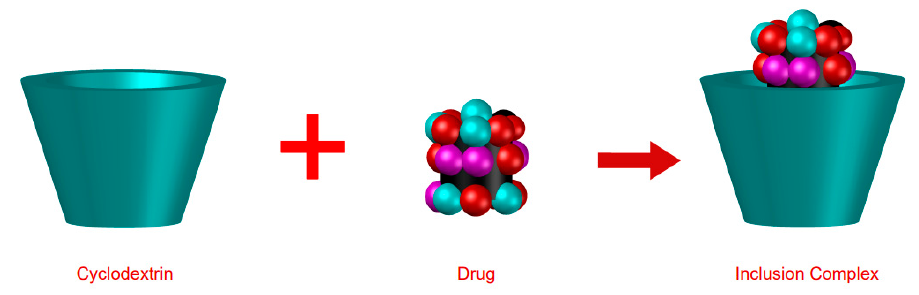
Figure 4. Formation of an inclusion complex.